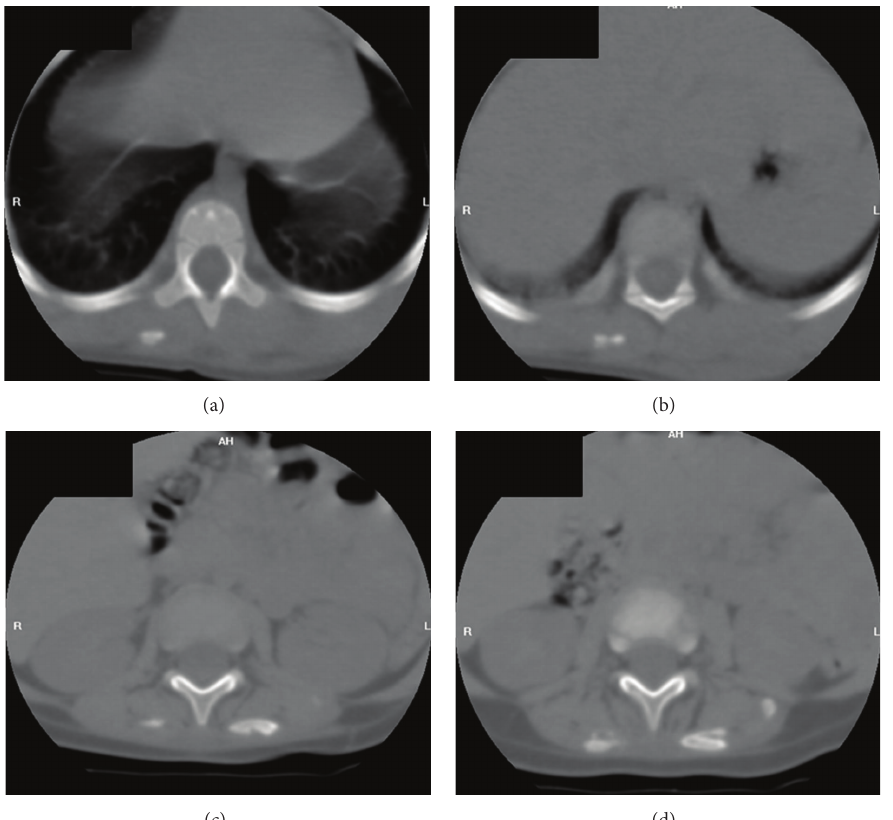
F 3: Noncontrast axial CT scan of lumbosacral spine showing multiple plaque-like calci�cations in paraspinal muscles, more on the le side, with diffuse muscle